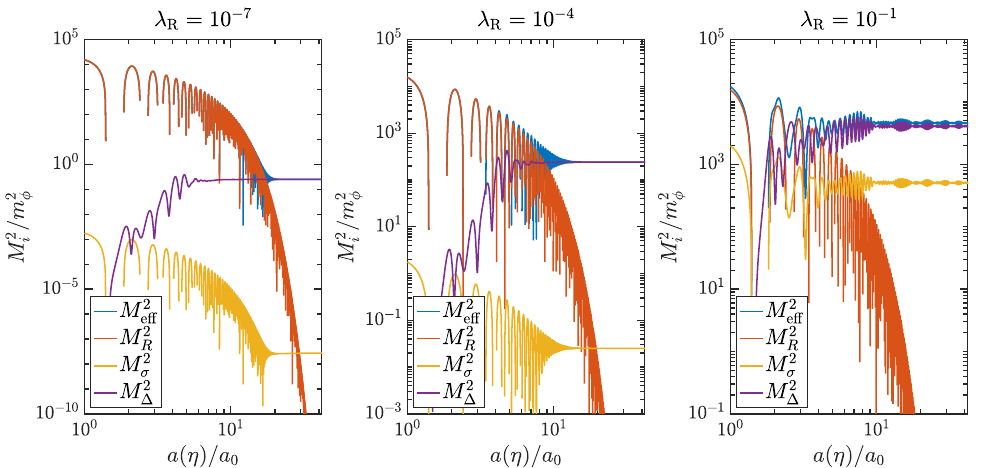
Figure 7 . The effective mass function M 2 (violet) and M 2 (yellow), defined in equations (5.1), for λ R ∈ { 10 − 7 , 10 − 4 , 10 − 1 } in the case ¯ ξ R = 50 σ and Γ ' 0 . 1 H 0 .